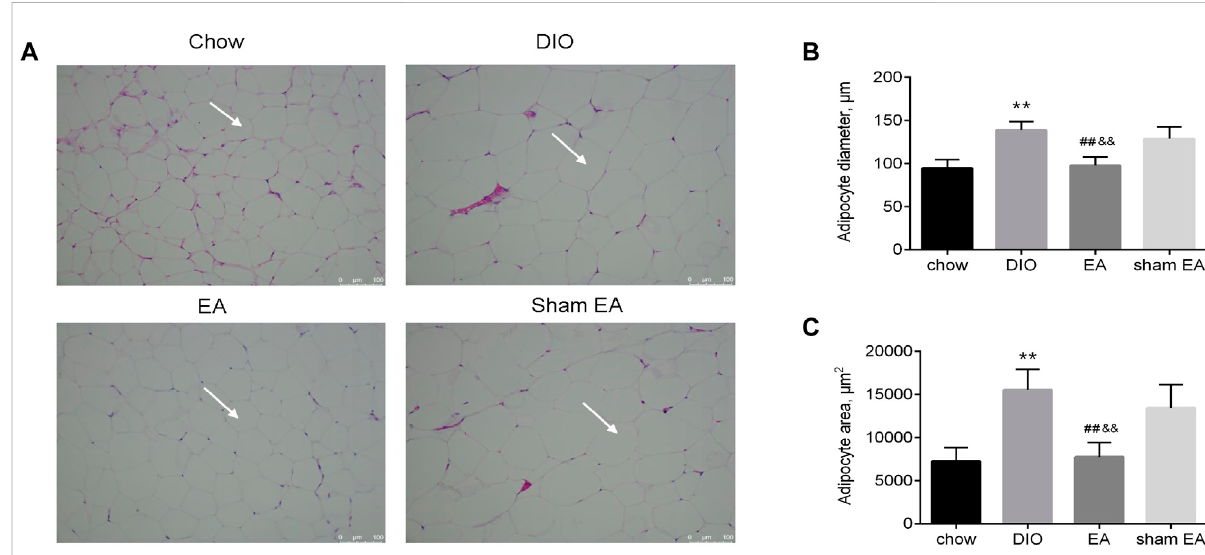
FIGURE 3 EA treatment reversed HFD-induced pathological morphological changes in the eWAT. (A) Representative H&E (×200) staining sections (scale bar,100 μ m).Thewhitearrowsindicateadipocyte, (B) adipocytediameter,and (C) adipocytearea.AlldataareexpressedasMean±SD( n =6ratsper group), ** p < 0.01 vs. chow; ## p < 0.01 vs. DIO; && p < 0.01 vs. sham EA. HFD, high-fat diet; eWAT, epididymal white adipose tissue; EA, electroacupuncture; DIO, diet-induced obesity. EA treatment modulated the expression of autophagy-related components in